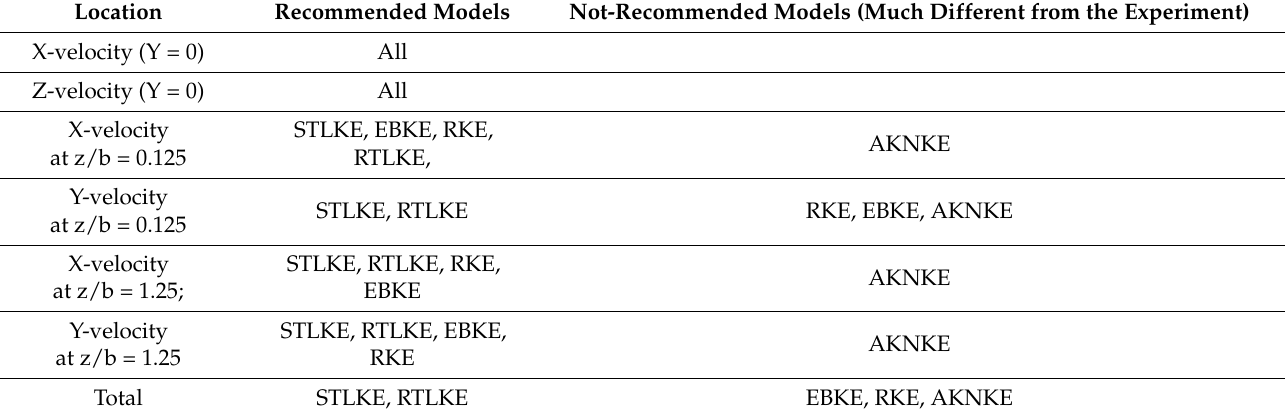
Table 11. Comparison of wind speeds in the high wind-speed area.